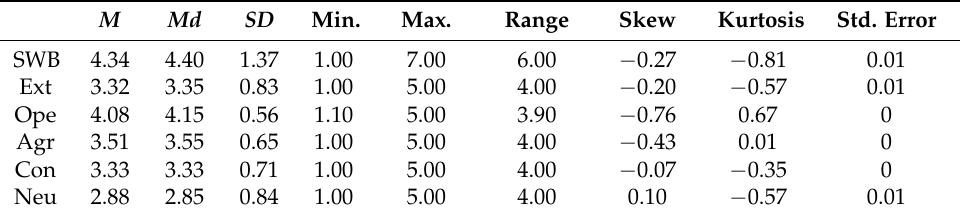
Table 1. Descriptive statistics for the observed FFM traits and SWB ( n = 21,122).